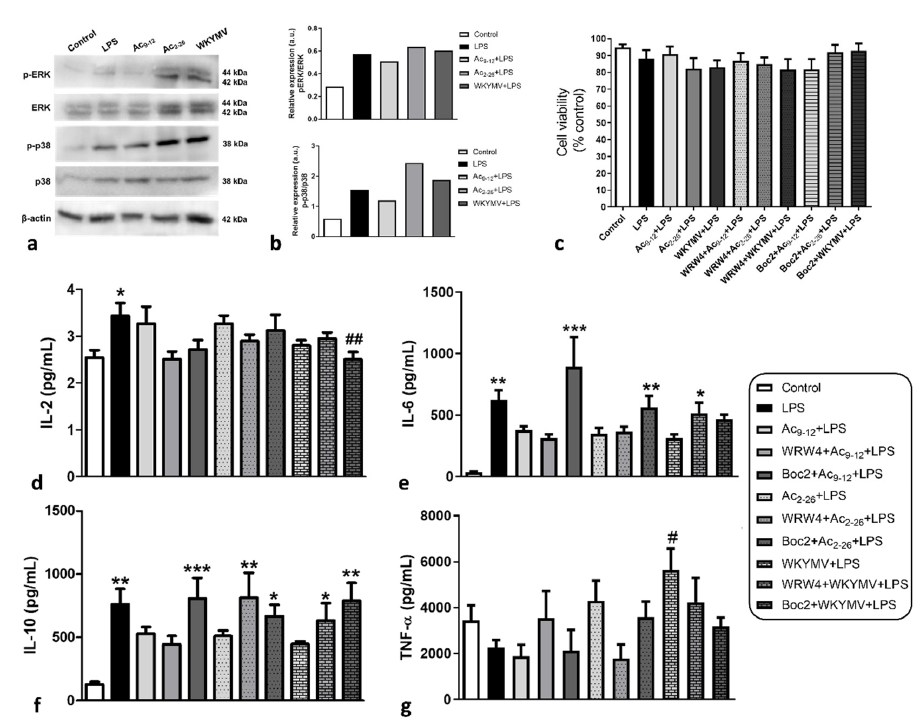
Figure 3. Effects of distinct pharmacological treatments on macrophage activation; 1 × 10 6 cells were submitted to the followed experimental conditions: control (culture medium); stimulated by LPS (1 µ g/mL); pre-treated with Ac 9-12 , Ac 2-26 , or WKYMV (3 µ M) and stimulated with LPS; after 24 h, cell lysates were analyzed. ( a ) Representative immunoblots demonstrate levels of p-p38, p38, p-ERK, and ERK in cell extracts (data show a representative blot from two independent experiments). B-actin was used as loading control. ( b ) Immunoreactive bands for kinases were semiquantified by densitometry and are expressed as arbitrary units (a.u.) of the ratio of p-p38/p38, p-ERK/ERK. ( c – g ) Experimental design: 1 × 10 4 cells were submitted to the followed experimental conditions: control; stimulated by LPS (1 µ g/mL); pre-treated with Ac 9-12 , Ac 2-26 , or WKYMV (3 µ M) and stimulated with LPS; pre-treated with Fpr antagonists (WRW4 or Boc2) plus Ac 9-12 , Ac 2-26 , or WKYMV and stimulated with LPS; after 24 h, cell lysates ( c ) or culture supernatants ( d – g ) were analyzed. ( c ) Cell viability was maintained in all experimental conditions. The percentage of viable cells was calculated by optical density normalization for control cells. Data are shown as mean ± S.E.M. of the cell ratio (%). ( d ) Levels of IL-2, ( e ) IL-6, ( f ) IL-10, and ( g ) TNF- α . After 24 h, data showed mean ± S.E.M. of cytokine levels ( n = 6–7/group). * p < 0.05, ** p < 0.01, *** p < 0.001 vs. Control; # p < 0.05, ## p < 0.01 vs. LPS (ANOVA, Bonferroni